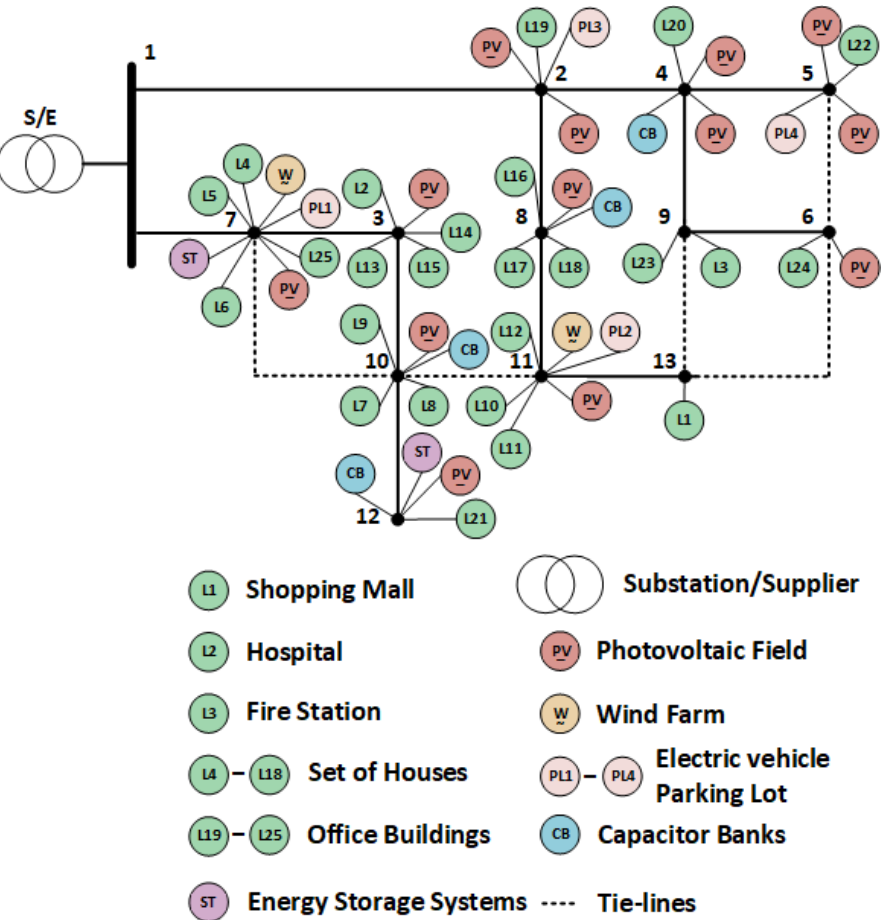
Figure 6. Single-line diagram of the 13-bus distribution